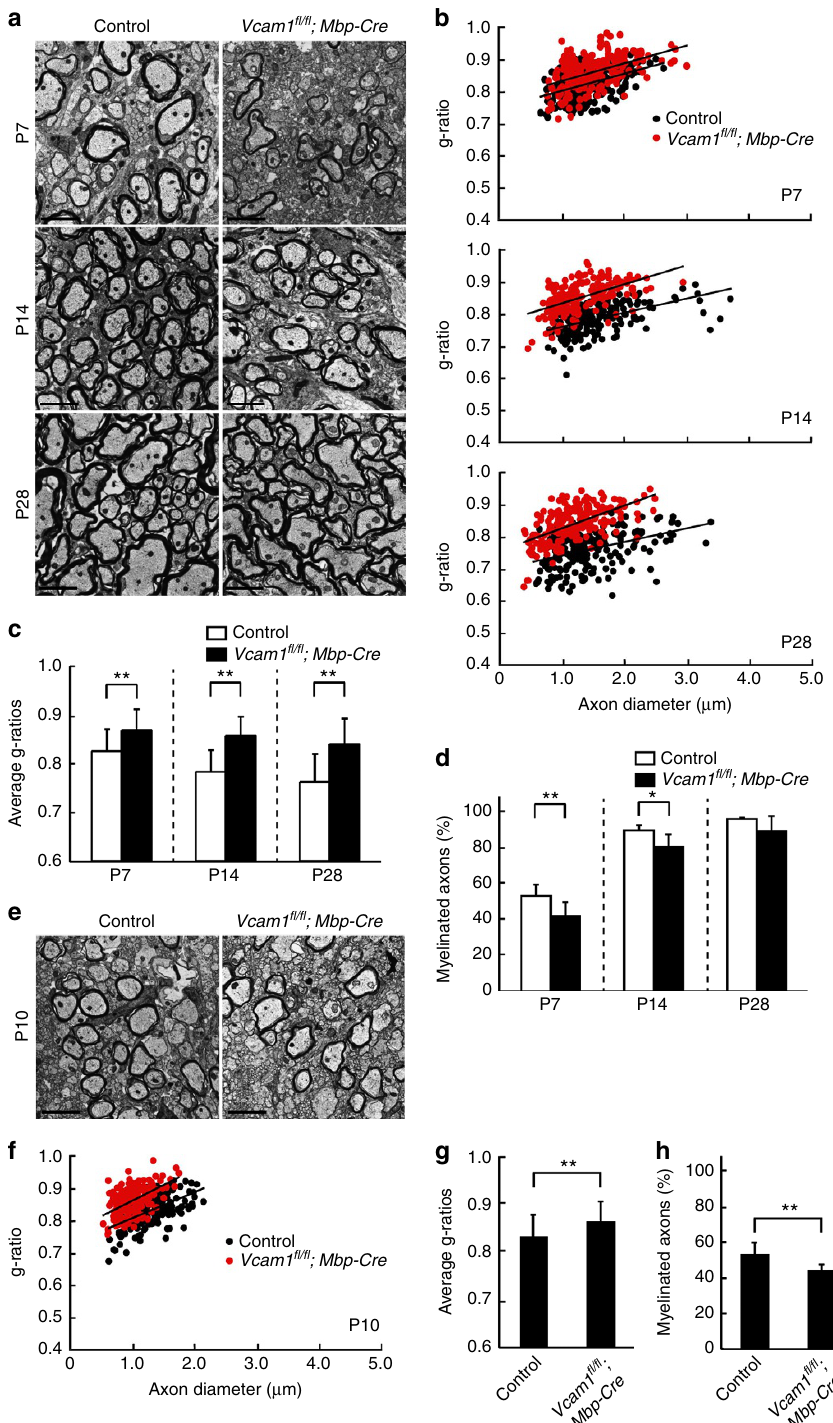
Figure 4 | Knockout of VCAM1 results in decreased myelin thickness during postnatal development. ( a – d ) Electron microscopic data of 7-, 14- and 28-day-old (P7, P14 and P28) spinal cords are shown. Data are representative. Scale bar, 2 m m. The g-ratios (200–300 myelinated fibres) are plotted for axon diameters. Average g-ratios are also shown. Data were evaluated using Student’s t -test (** P ¼ 1.54E (cid:2) 21 (P7), 1.39E (cid:2) 48 (P14) or 3.50E (cid:2) 37 (P28); n ¼ 208–282 axons of two independent experiments). The percentage of myelinated axons is indicated. Data were evaluated using Student’s t -test (** P ¼ 0.00963 (P7), * P ¼ 0.0135 (P14) or non-significance (P28); n ¼ 6–8 areas of two independent experiments). ( e – h ) Electron microscopic data of 10-day-old corpus callosum are shown. Data are representative. Scale bar, 2 m m. The g-ratios (200–300 myelinated fibres) are plotted for axon diameters. Average g-ratios are also shown. Data were evaluated using Student’s t -test (** P ¼ 3.47E (cid:2) 10; n ¼ 209–224 axons of two independent experiments). The percentage of myelinated axons is indicated. Data were evaluated using Student’s t -test (** P ¼ 0.00523; n ¼ 8 areas of two independent